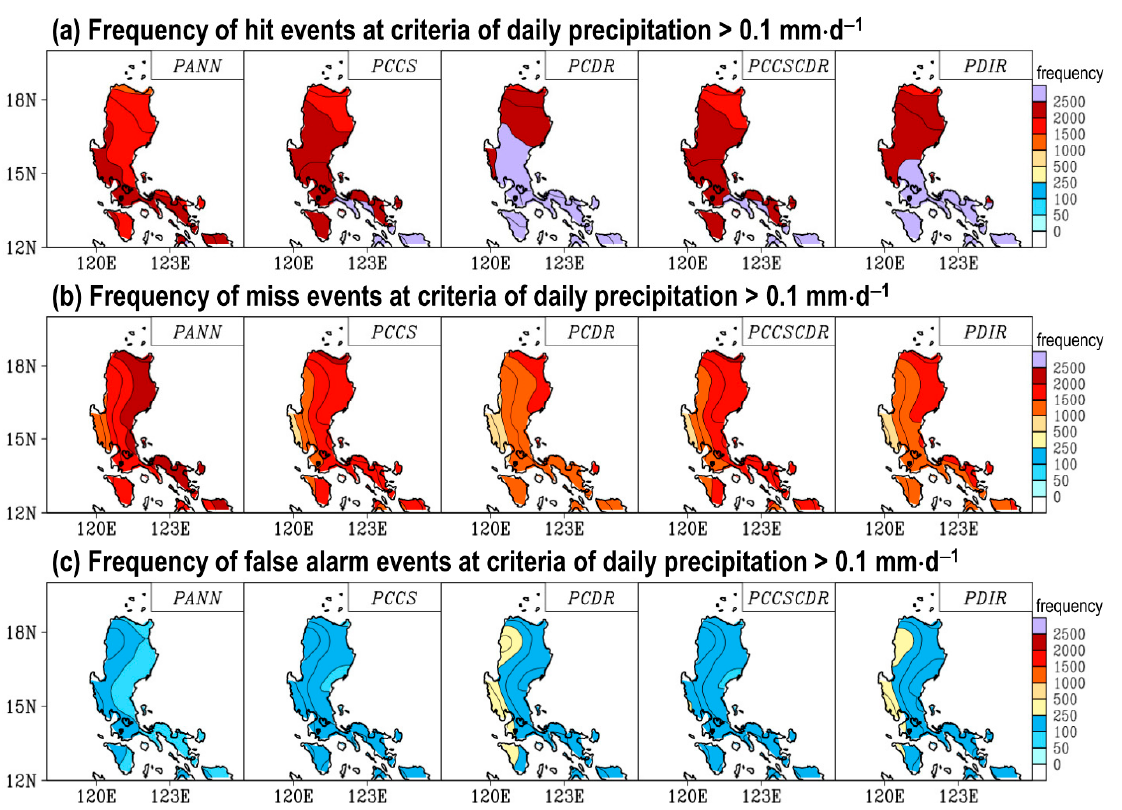
Figure 10. (a) The frequency of hit events at criteria of daily precipitation of >0.1 mm ⋅ d − 1 from 2013–2015 over Luzon. ( b ) as in ( a ), but for miss events; and ( c ) as in ( a ), but for false alarm events. The contour intervals in ( a ), ( b ), and ( c ) are 250 mm·d − 1 , 250 mm·d − 1 , and 50 mm·d − 1 , respectively.